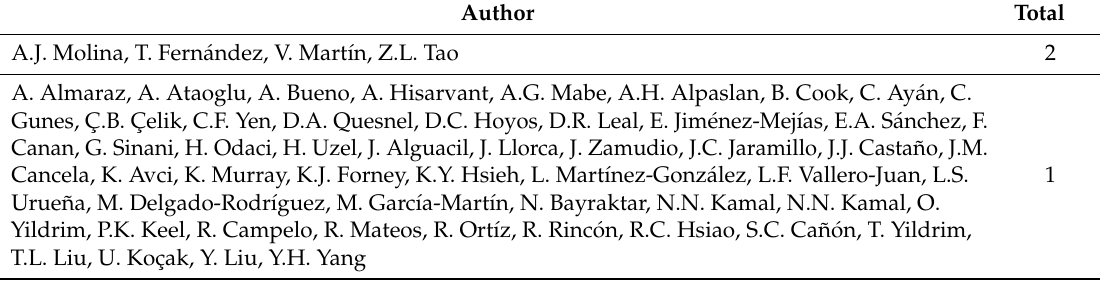
Table 1. Authors’ names and number of publications.